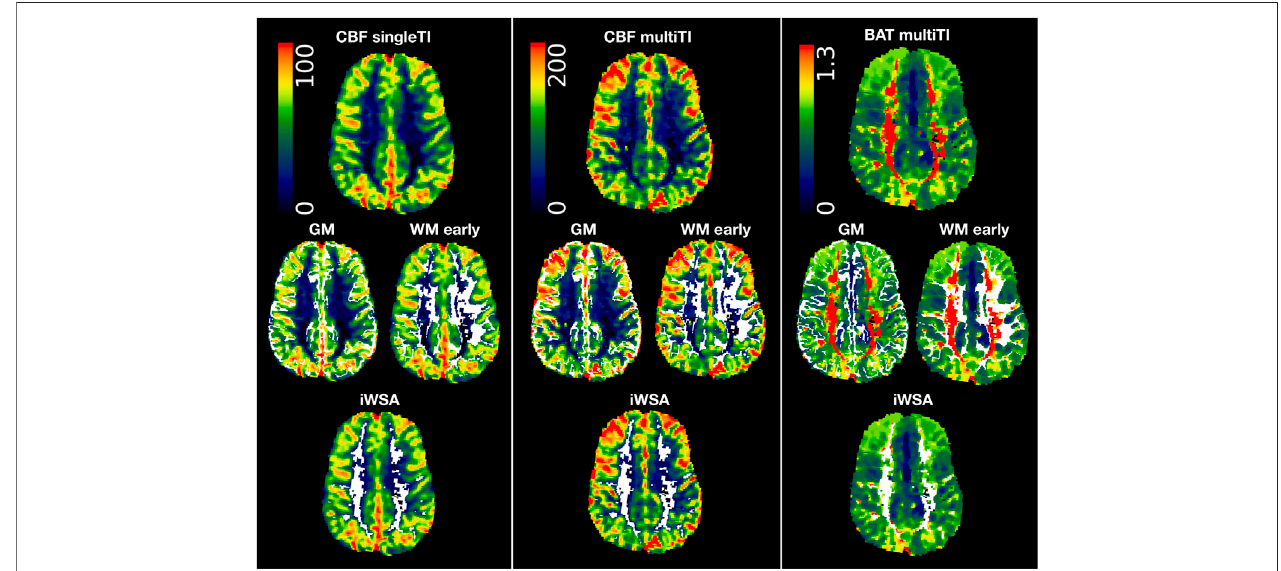
FIGURE 1 | Regions of interest. Showing regions of interest (i.e., grey matter (GM), white matter with early arrival times (WM early), white matter with late arrival times/individual watershed areas (WM late, iWSA) overlaid in white on cerebral blood fl ow (CBF) and bolus arrival time (BAT) maps from the single in fl ow time (SingleTI) and multi in fl ow time (multiTI) sequences in a representative participant with sickle cell anemia (male, 12 years of age).